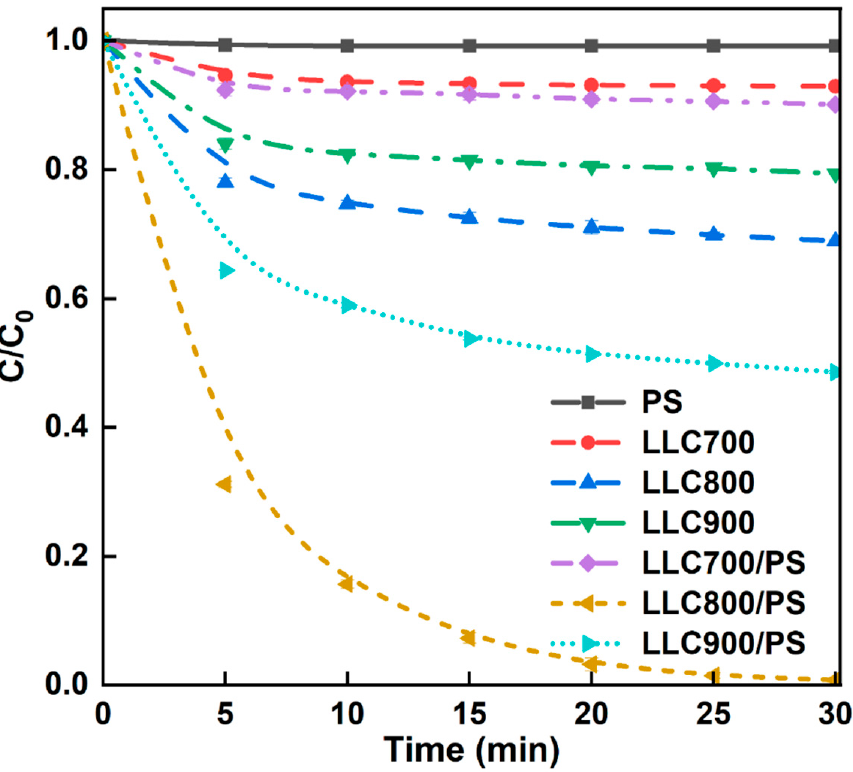
Figure 5. Removal effect of AO7 by different systems. Reaction conditions: LLC = 0.25 g/L, PS = 4 g/L, AO7 = 200 mg/L, temperature = 25 °C and pH = 6.4 ± 0.1.